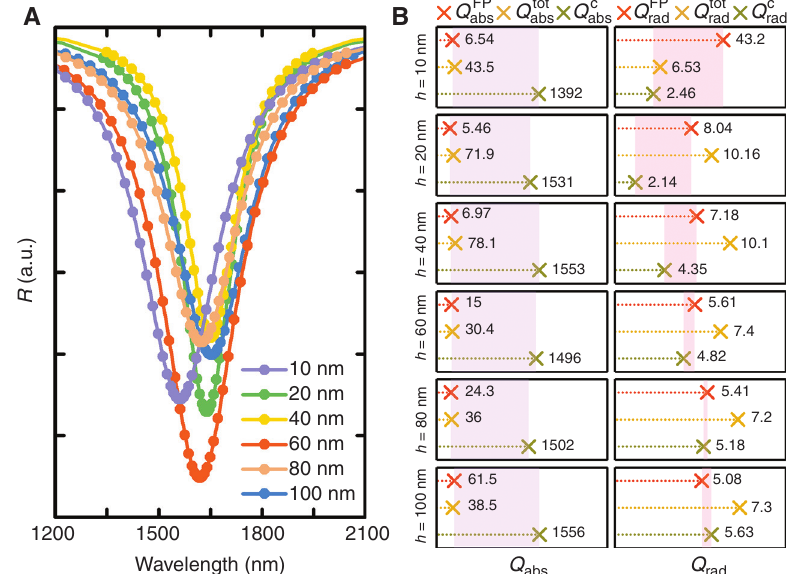
Figure 3: Comparisons of absorption and radiation characters between FP mode, cavity mode, and the total structure, respectively. (A) Measured reflectance curves with different h values treated by the Lorentzian fitting. (B) Left column: comparison between the , Q C , Q and tot Q at different h values. Right column: comparison between the experimental values of FP experimental values of FP abs abs abs tot Q at different h values. Majority of tot Q values are in between FP rad abs Q and C Q (beyond the colorful larger than both FP rad rad